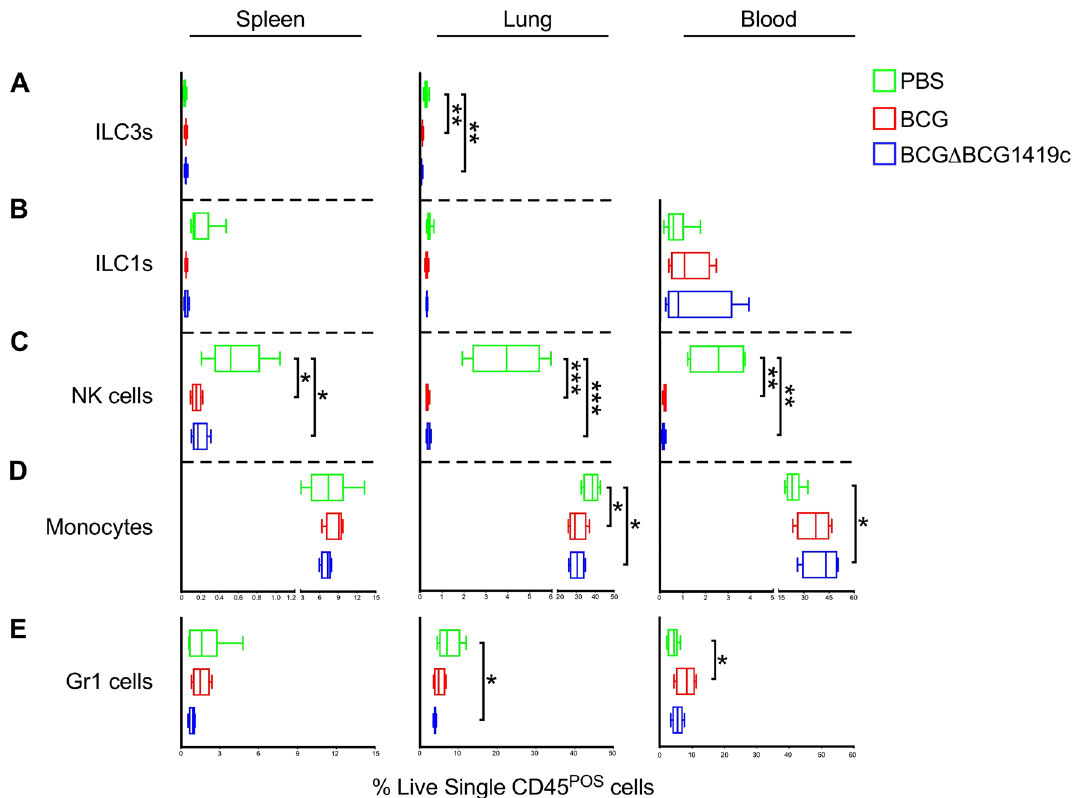
Figure 3. Innate immune subset frequencies in BCG- and BCGΔBCG1419c-immunized mice. Innate immune subset (i.e. ILC, NK cell, monocyte and Gr1 cell) frequencies in BCG- and BCGΔBCG1419c-immunized mice, as well as PBS controls, were measured in the spleen, lung and blood on post-immunization day 18. Shown are the frequencies of ( A ) ILC3s, ( B ) ILC1s, ( C ) NK cells, ( D ) monocytes and ( E ) Gr1 cells in the spleen (left column), lung (middle column) and blood (right column), as gated off of live single CD45 + cells. ILCs were gated off CD3 − CD19 − CD127 + , and different subsets were determined according to the expression of CRTH2 vs cKit: ILC1, CRTH2 − cKit − ; ILC2, CRTH2 + cKit +/− ; ILC3, CRTH - cKit + . Boxes represent data from 3 mice per group; asterisks represent a statistically significant difference between indicated rows (*p ≤ 0.05; **p ≤ 0.005; ***p ≤